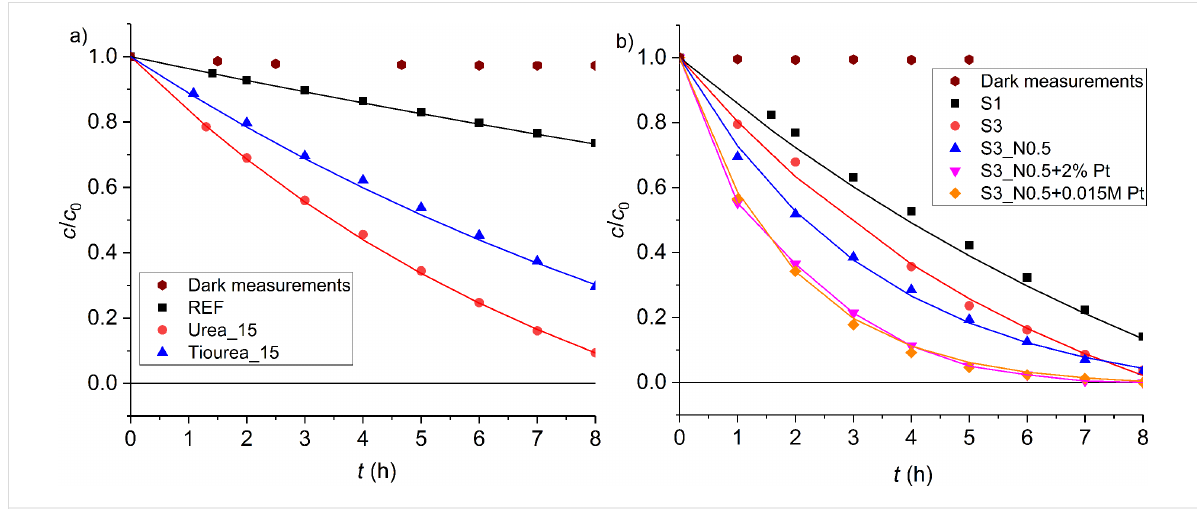
Figure 7: Photocatalytic activity of different samples a) synthesized with HCl; dark measurements performed for sample REF and b) synthesized with H 2 SO 4 ; dark measurements performed for sample